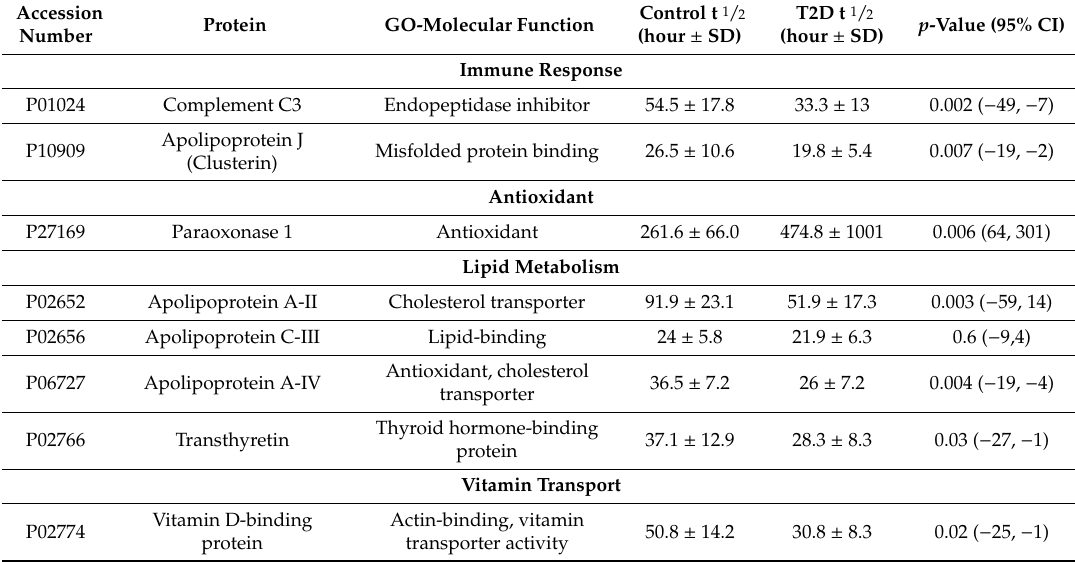
Table 3. Half-lives of HDL proteins in healthy controls (n = 8) and subjects with T2D (n = 9).